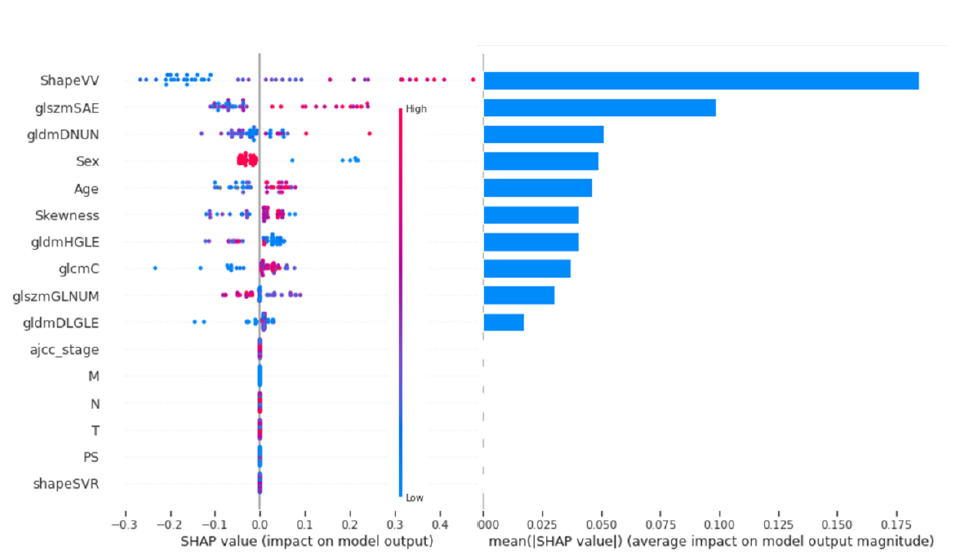
Figure 4. Ranking of features on their Shapley Value. gldmDNUN: gldm Dependence Non Uniformity Normalized; gldmDLGLE: gldm Large Dependence Low Grey Level Emphasis; glcmC: glcm Correlation; glszmGLNUN: glszm Grey Level Non Uniformity Normalized; glszmSAE: glszm Small Area Emphasis.